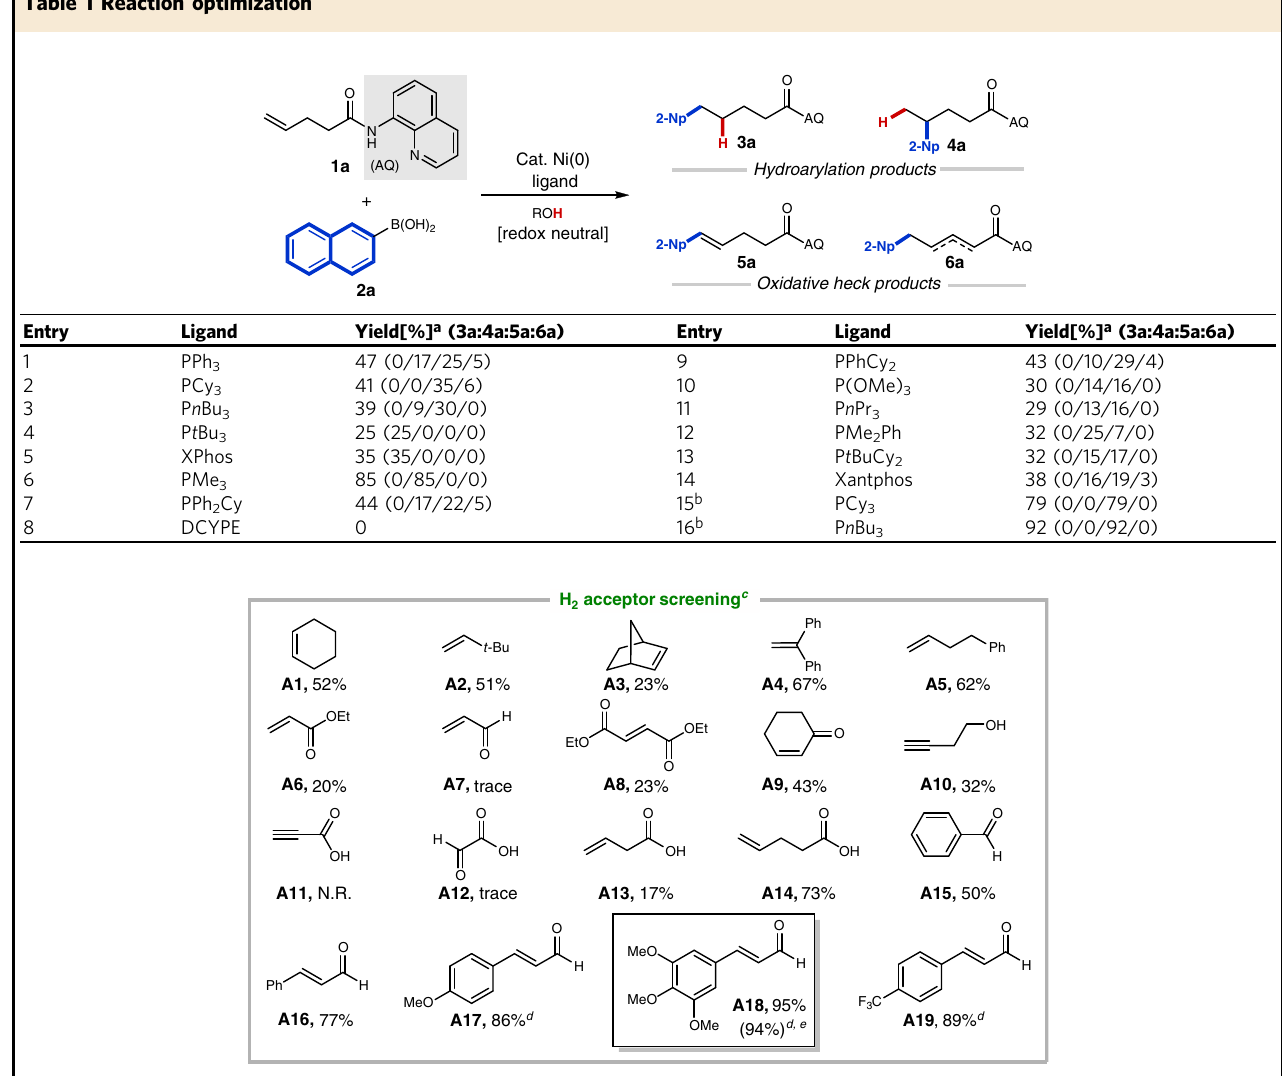
Table 1 Reaction